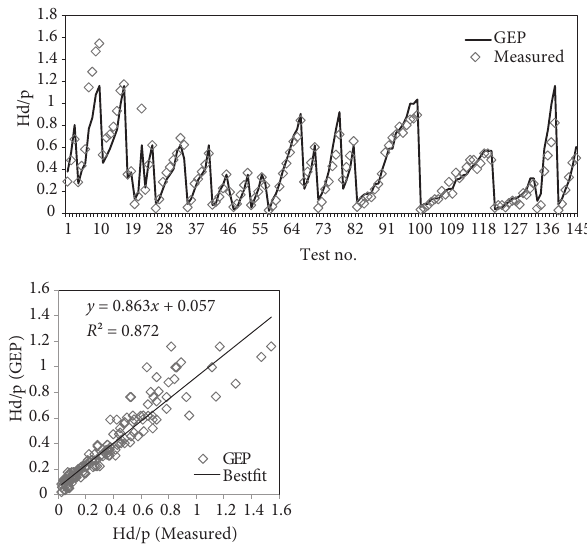
/p versus measured ones for train d